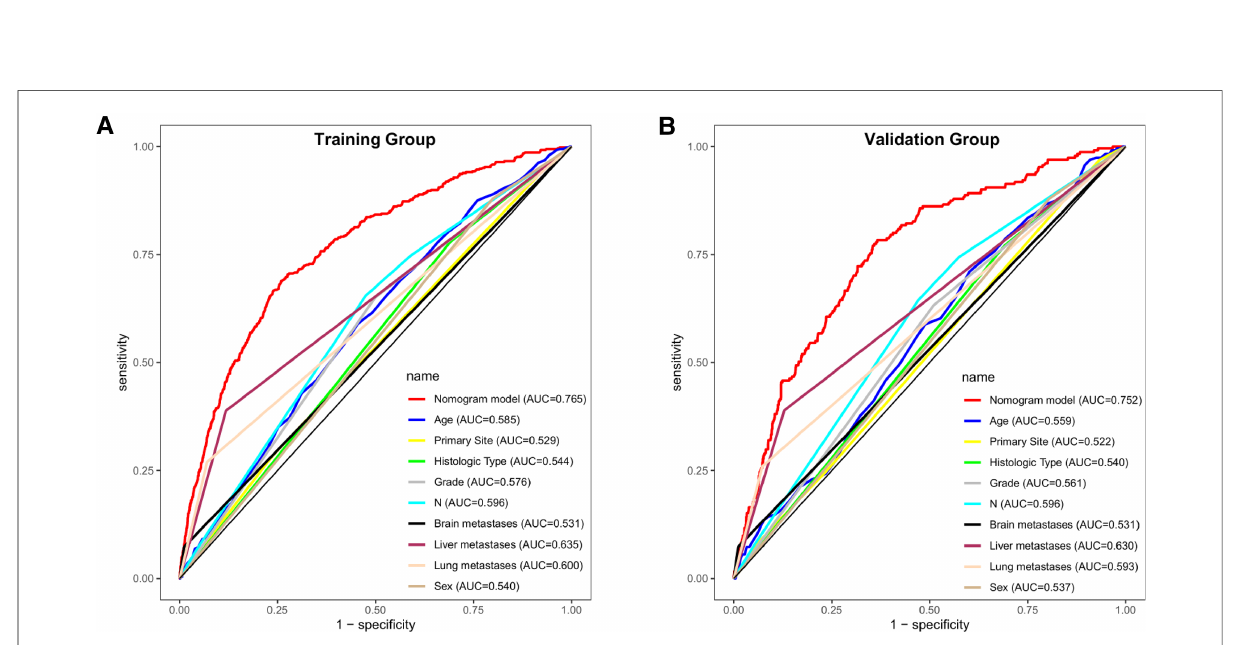
FIGURE 4 ROC curves and AUC values of predictive nomograms and each predictor in the training group ( A ) and validation group ( B